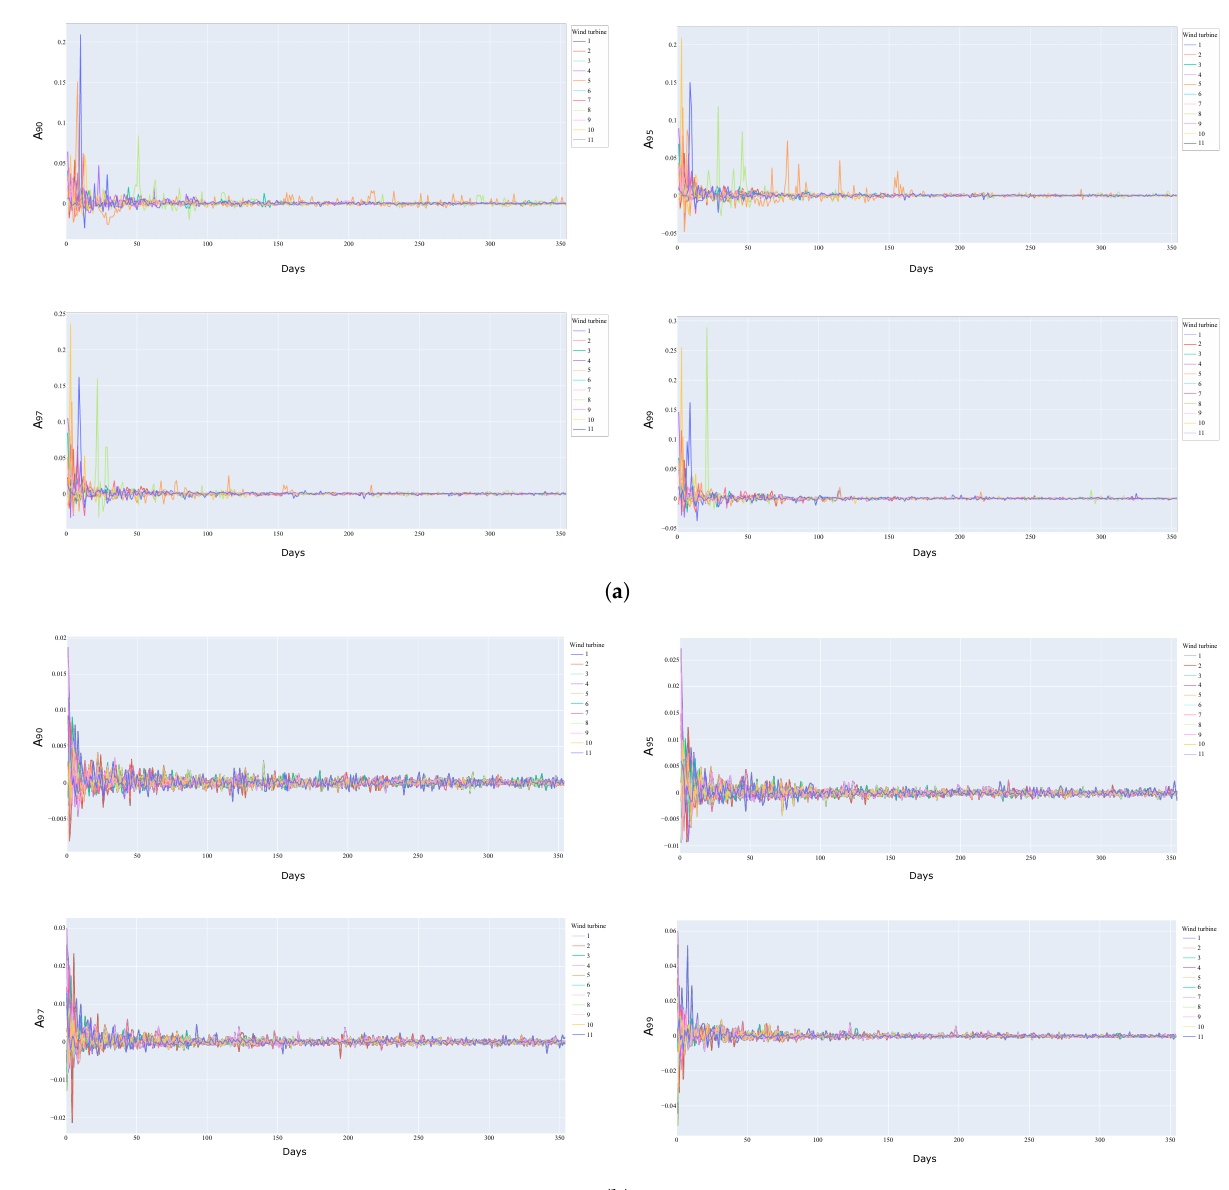
Figure 9. Temperature alarm thresholds converging over time. ( a ) generator bearing alarm conver- gence; ( b ) generator phase winding alarm